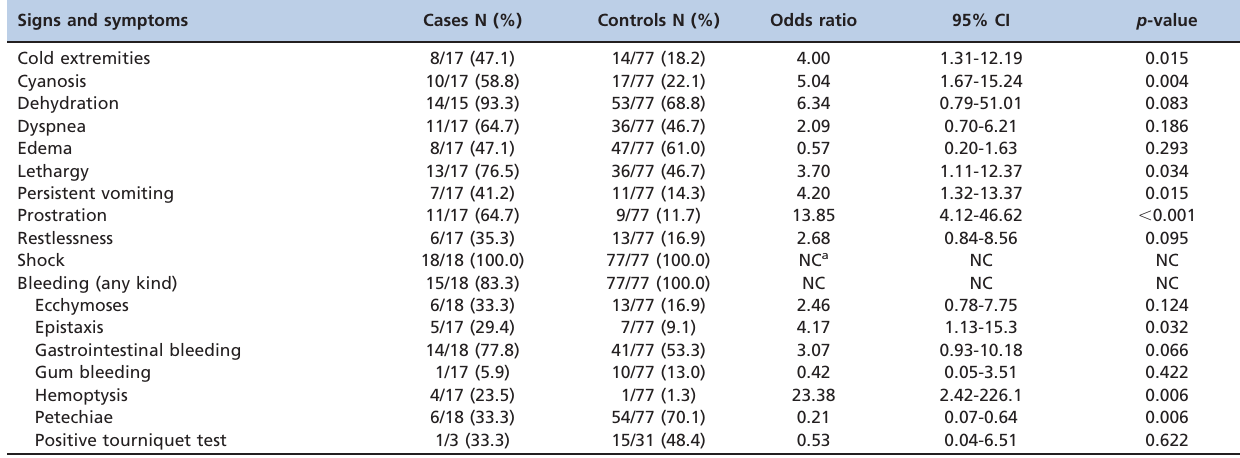
Table 2 - Association between clinical characteristics and death in children with severe dengue. Signs and